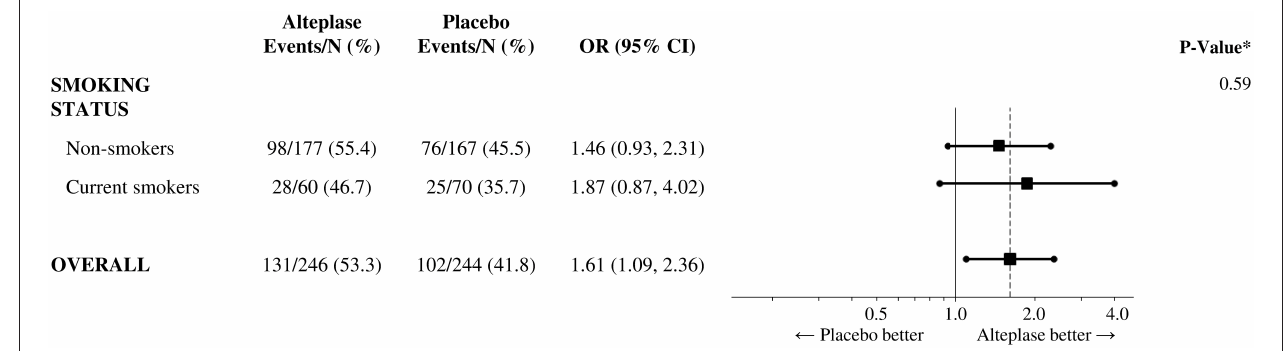
FIGURE 2 | Treatment efficacy of i.v. thrombolysis according to smoking status. Shown are odds ratios for favorable outcome (modified Rankin Scale score 0–1) in current smokers and non-smokers as well as in all participants. * P -value for the test of interaction between treatment group and smoking status. CI stands for confidence